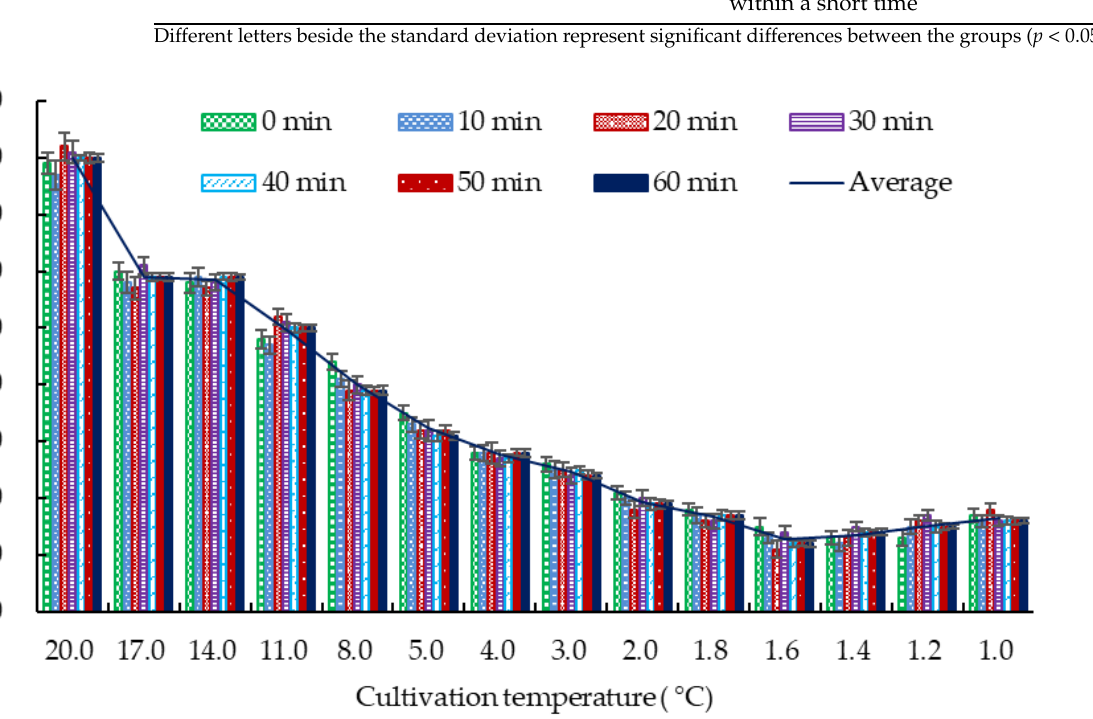
Figure 2. Effects of different temperatures on the survival time of the crucian carp. Different letters above the standard deviation represent significant differences between the groups ( p < 0.05).